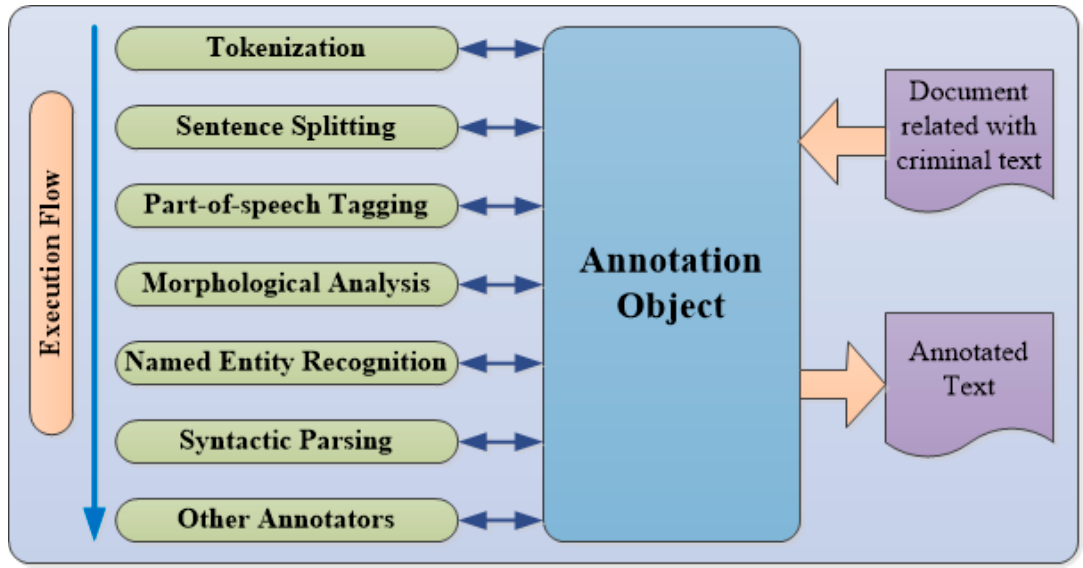
Figure 3. Working mechanism of annotators.